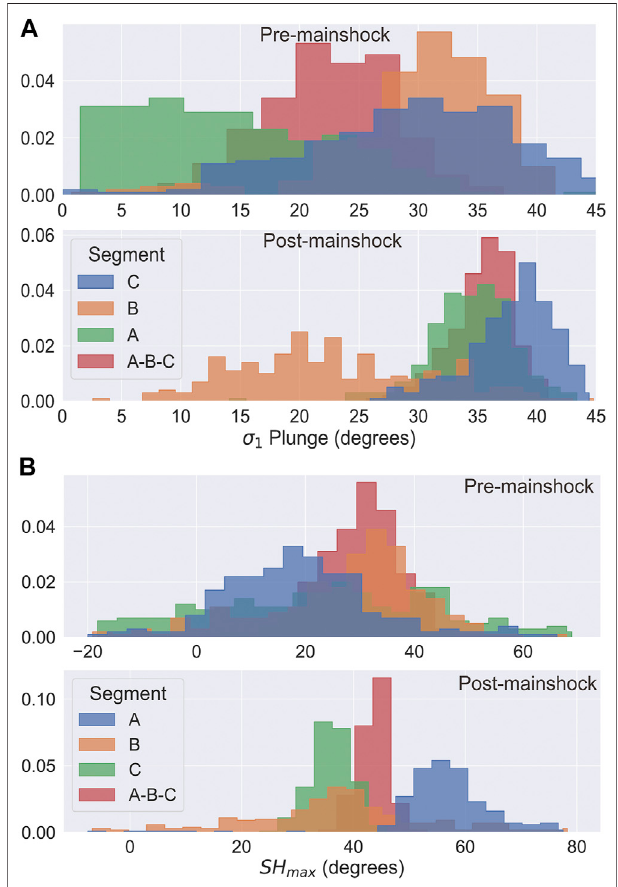
FIGURE 6 | Histograms of (A) σ 1 plunge and (B) SH max for outer forearc segments A-B-C, A, B and C estimated in this study. Each histogram represents the variation in samples taken from bootstrap resampling method.